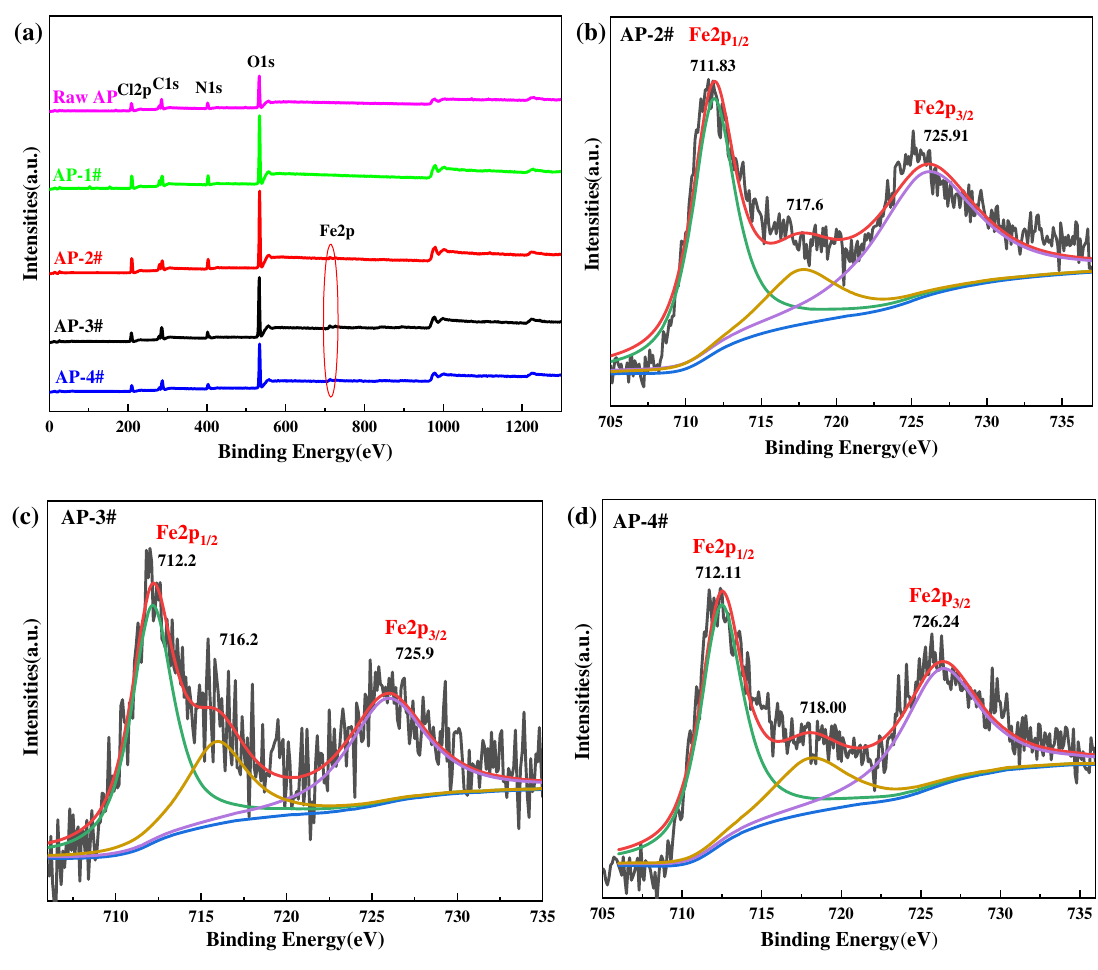
Figure 6. X-ray photoelectron spectra (XPS) and Fe2p XPS of laminated AP